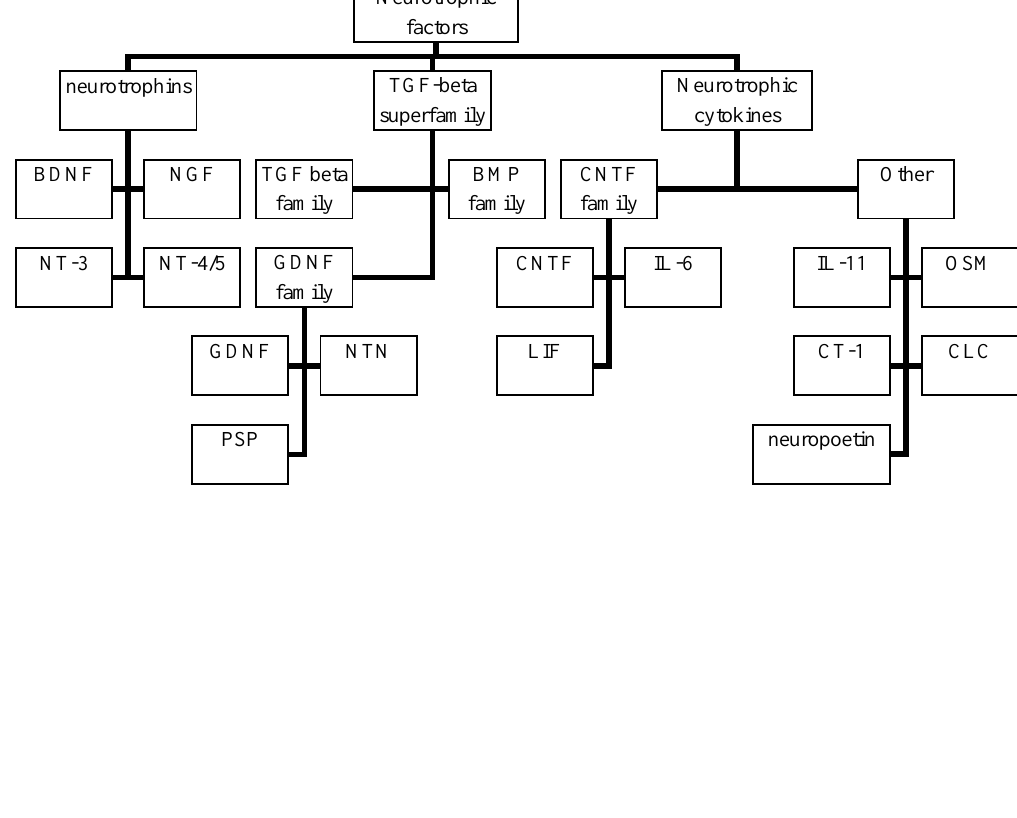
1. Neurotrophic factor family classification. NGF: nerve growth factor, BDNF: brain-derived neurotrophic factor, NT-3: neurotrophin 3, NT-4/5: neurotrophin 4/5, TGF beta: transforming growth factor beta, GDNF: glial derived neurotrophic factor, BMP: bone morphogenic proteins, NTN: neurturin, PSP: persephin, CNTF: ciliary neurotrophic factor, IL-6: interleukin 6, LIF: leukemia inhibitory factor, IL-11: interleukin 11, OSM: oncostatin M, CT-1: kardiotrophin-1, CLC: cardiothrophin - like cytokine.